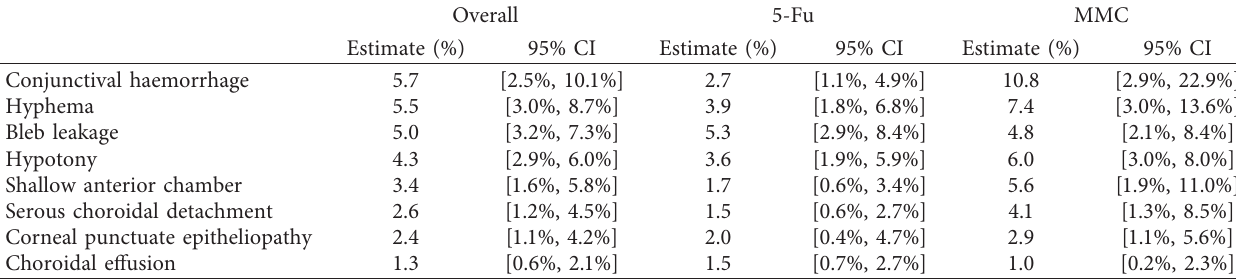
Table 2: Estimates with 95% confidence interval for complication rates after bleb